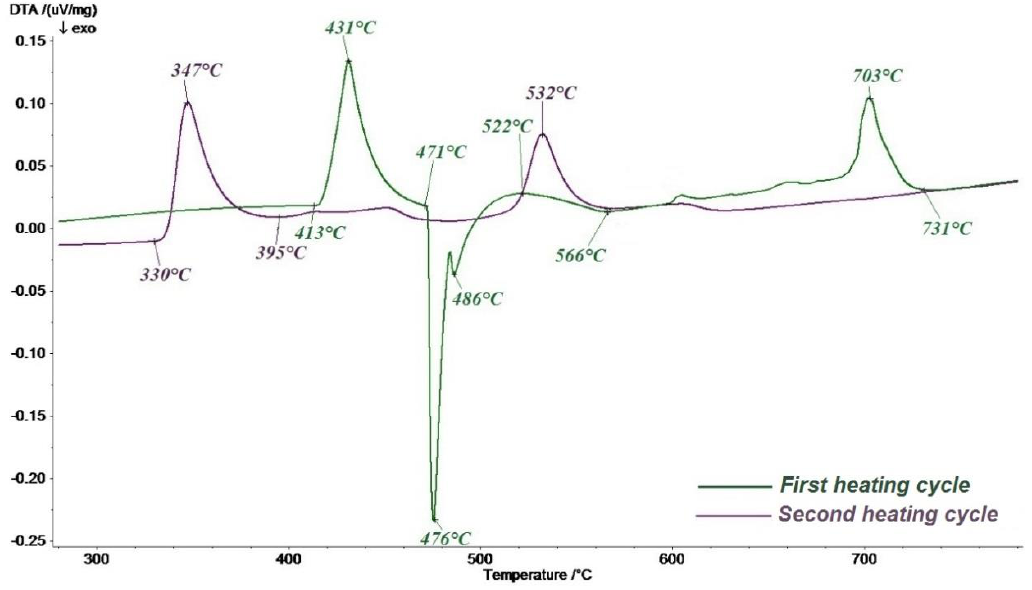
Figure 1. Thermograms of the first (green) and second (purple) heating cycle of the sample Mg–Zn– KCl–NaCl–CaCl 2 –NdF 3 up to 800